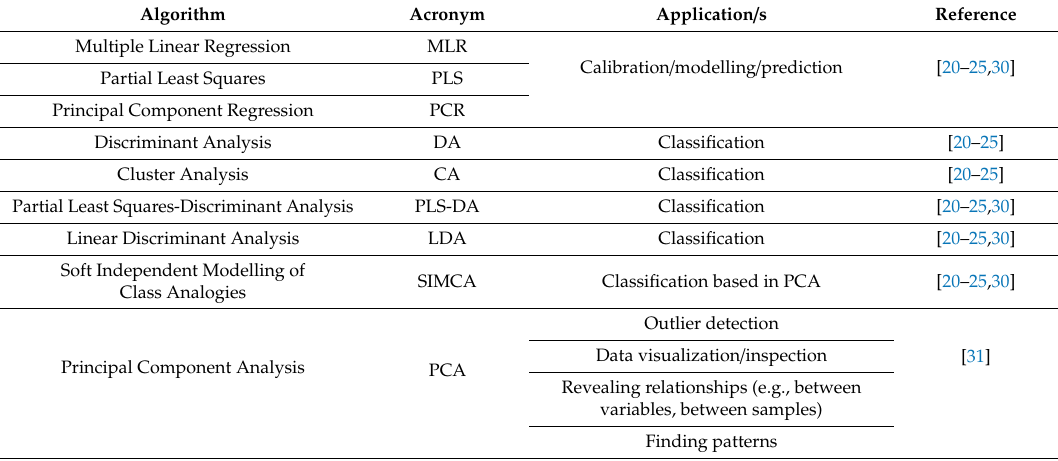
Table 1. Commonly used algorithms and corresponding application in food research and